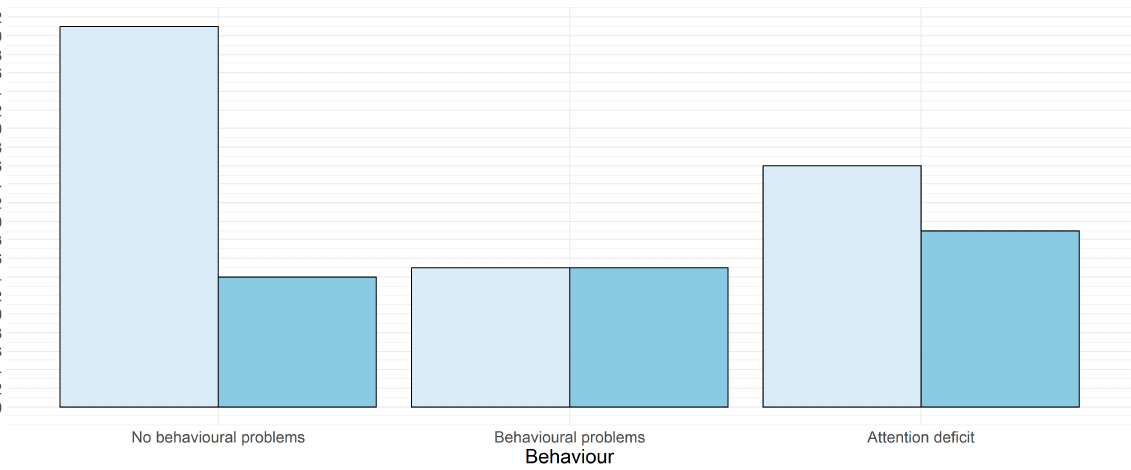
Figure 2. IQ changes (more or less 11 points) in patients subdivided according to behavioral findings. Key to figures: light blue < 11 points, blue ≥ 11 points.